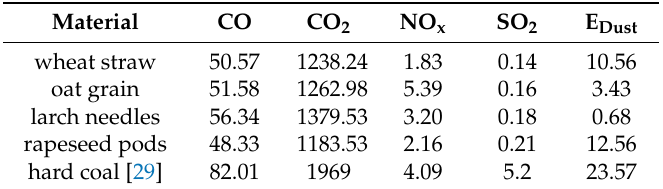
Table 2. Emission factors for analysed biomass and coal (in kg · Mg − 1 ).